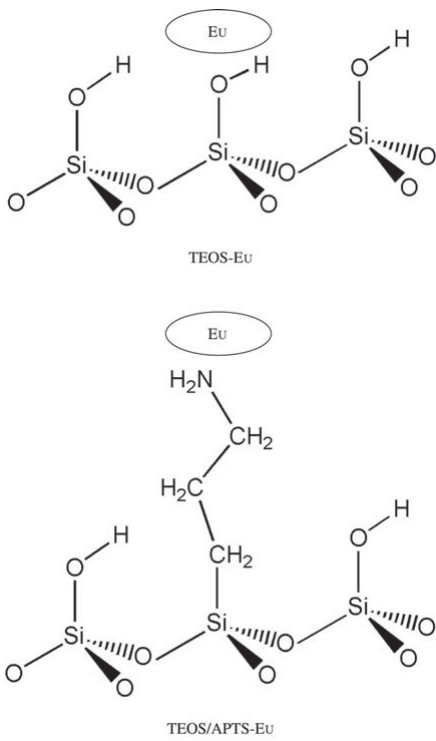
Scheme 1. Schematic representation of the silica particles (TEOS) and modified silica particles (TEOS/APTS) with Eu III compounds.